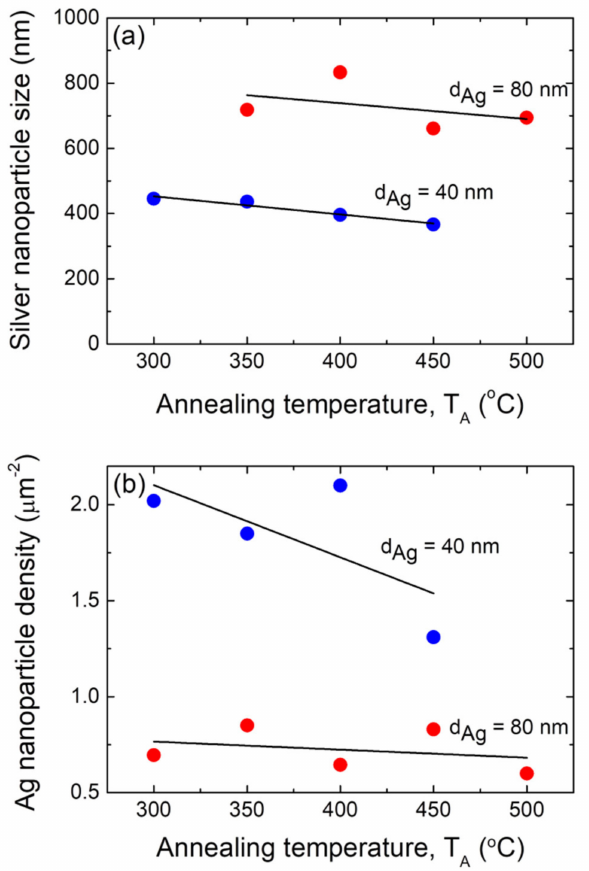
Figure 5. ( a ) Plot of the average size of the silver nanoparticles as a function of the annealing temperature T A of the annealing step during the SSD process. ( b ) Plot of surface density of the silver nanoparticles as a function of the annealing temperature T A during the annealing step of the SSD process. Two different precursor silver layer thickness were studied, i.e., d Ag = 40 nm (blue circles) and 80 nm (red circles). In all of these samples, the heat-up region program previously depicted has been applied. The black lines are a guide for the